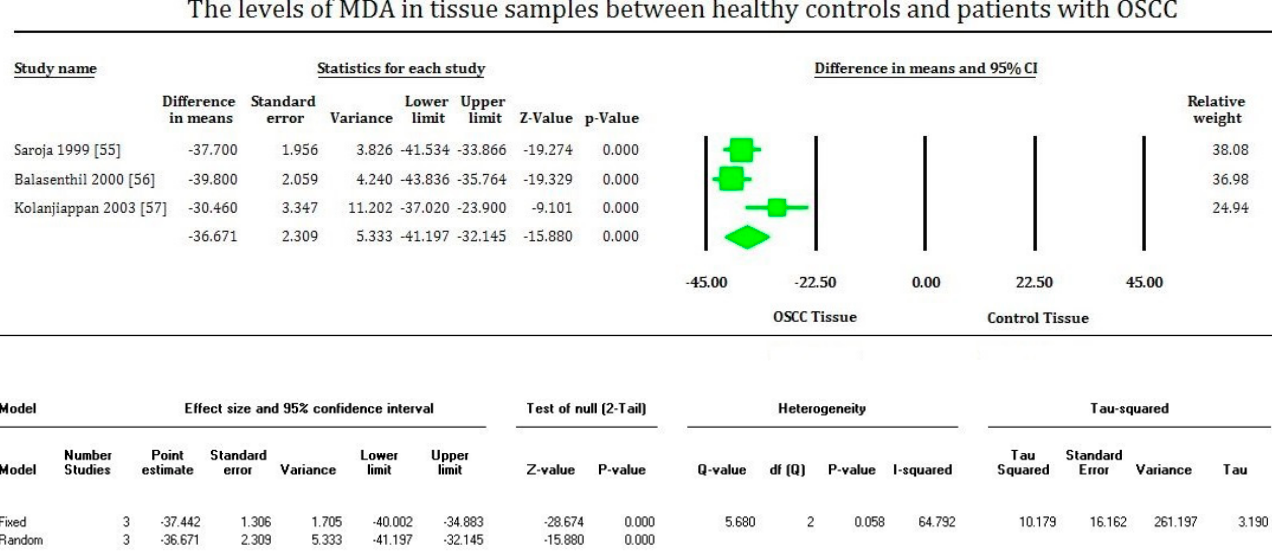
Figure 4. Forest plot shows mean difference estimates with 95% confidence intervals representing differences in salivary levels of MDA between oral squamous cell carcinoma group and healthy controls.